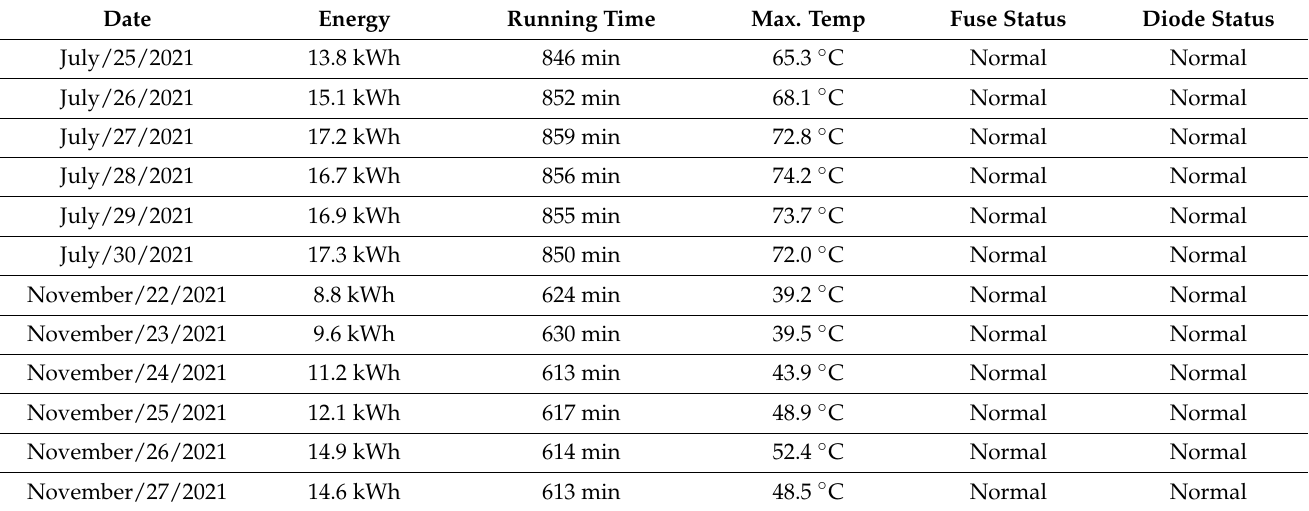
Table 2. The PV junction box information stored in the